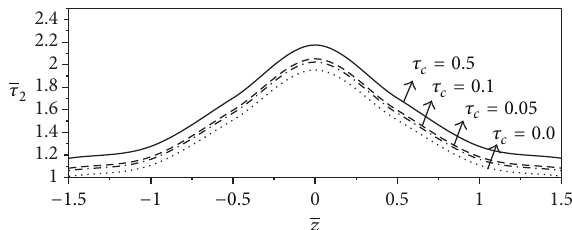
Figure 8: Comparison of cosine- and bell-shaped stenosis shapes.